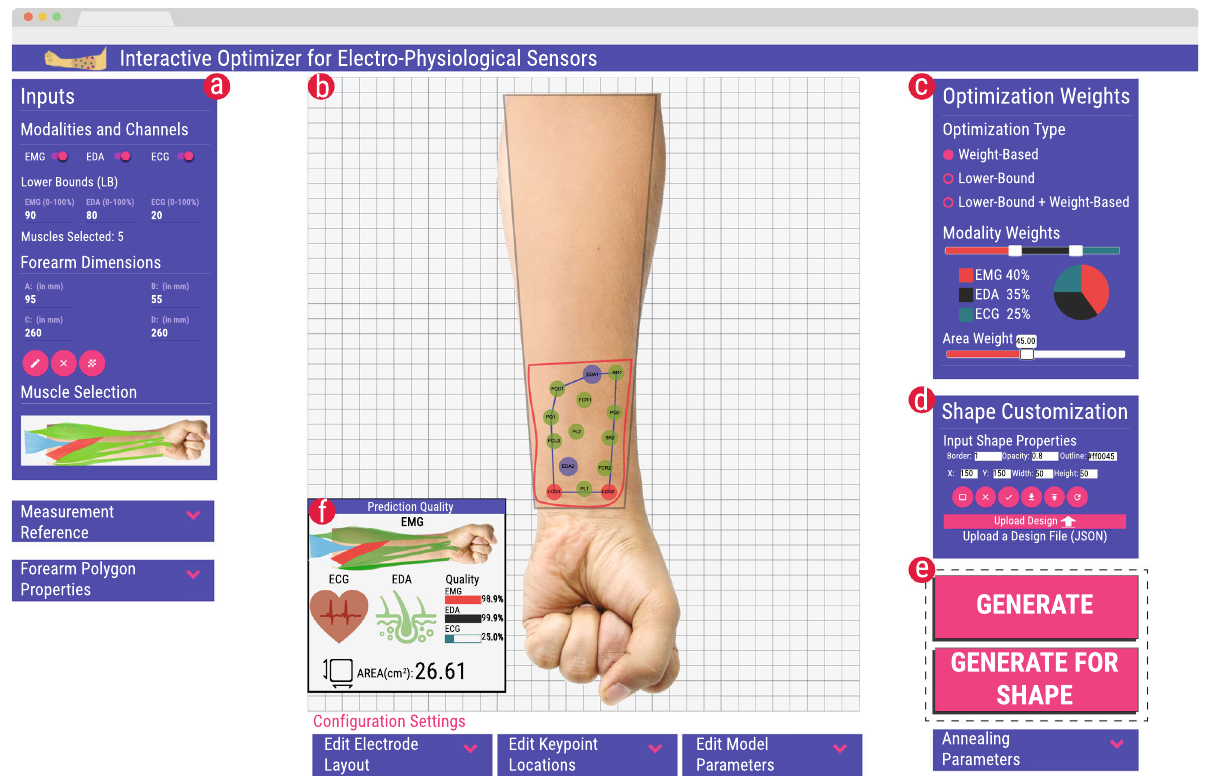
Fig. 2 Screenshot of the graphical design tool for interactively generating and inspecting optimized results. a Input panel for selecting the modalities and muscles, setting forearm dimensions and setting the lower bounds. b The canvas area where the generated designs are visualized. Designs can be fi ne- tuned by drawing a desired location and shape or dragging individual electrodes. c Panel for choosing the optimization type, weights for each of the modalities, and overall sensor area. d Shape customization panel for fi ne-tuning the properties related to the sensor shape. Additionally, this panel also allows for uploading existing designs and exporting the current designs. e Buttons for one-click automatic generation of the layout. The result is displayed in real-time in the canvas area. f Panel visualizing quality metrics for the generated layout. Advanced functionality for use by experts can be accessed through drop-down panels. This includes functions for adjusting and editing the electrodes in the generated solution, adjusting the internal parameters of the model, tweaking the optimization parameters, and adjusting the appearance of the forearm polygon. The work fl ow for using the tool is shown in Supplement tool is shown in Supplementary Video